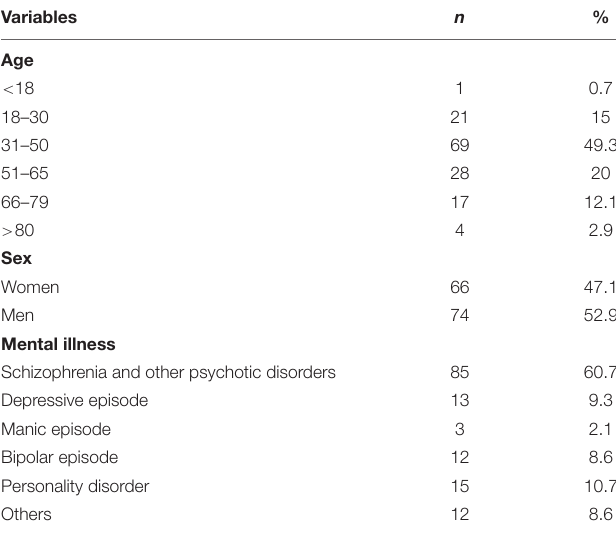
TABLE 1 | Main sociodemographic characteristics of the sample ( n =